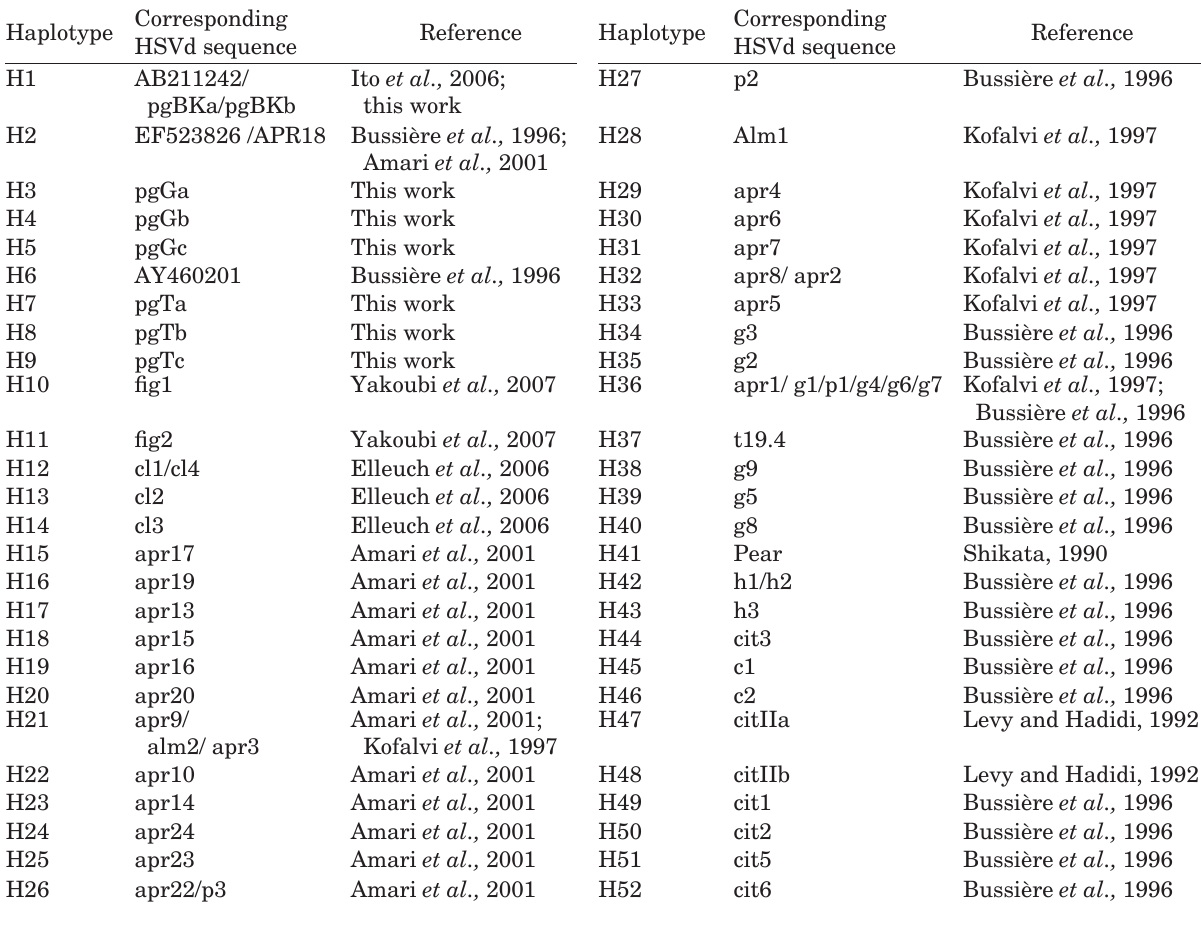
Table 1. Hop stunt viroid (HSVd) haplotypes deduced from sequence variants. The Tunisian HSVd-pomegranate isolates mentioned in this work are: pgBK, pomegranate isolates from the Beni Khalled region; pgG, pomegranate isolates from the Gabes region; pgT, pomegranate isolates from the Testour region. HSVd isolates included in sequence comparisons and in phylogenetic analysis were retrieved from data bases (http://www.callisto.si.usherb. ca~jpperra/viroids/hsv/html; Bussière et al. (1996). Corresponding Haplotype HSVd